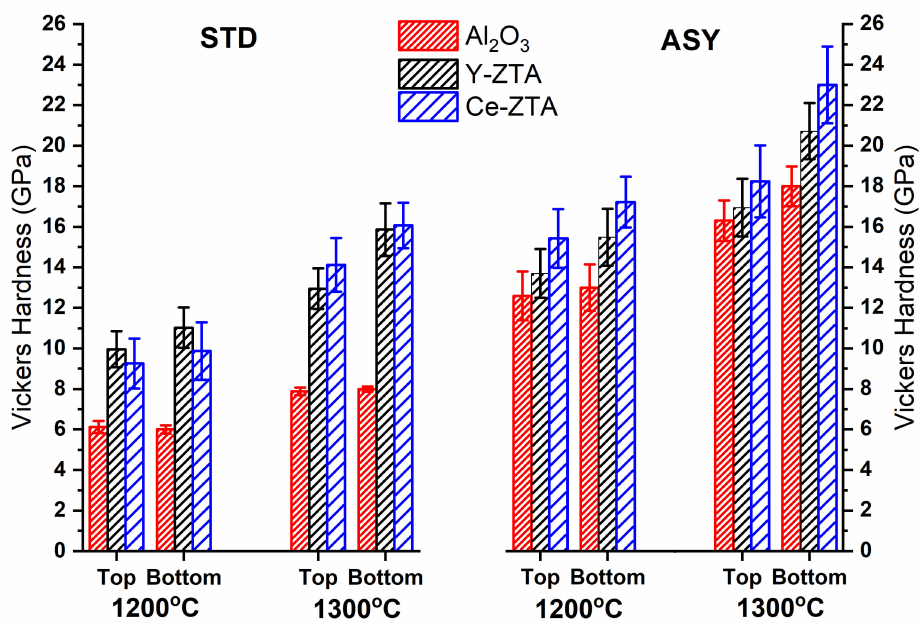
Figure 10. Vickers hardness of the samples fabricated in ASY and STD configurations at 1200 ◦ C and 1300 ◦ C set sintering